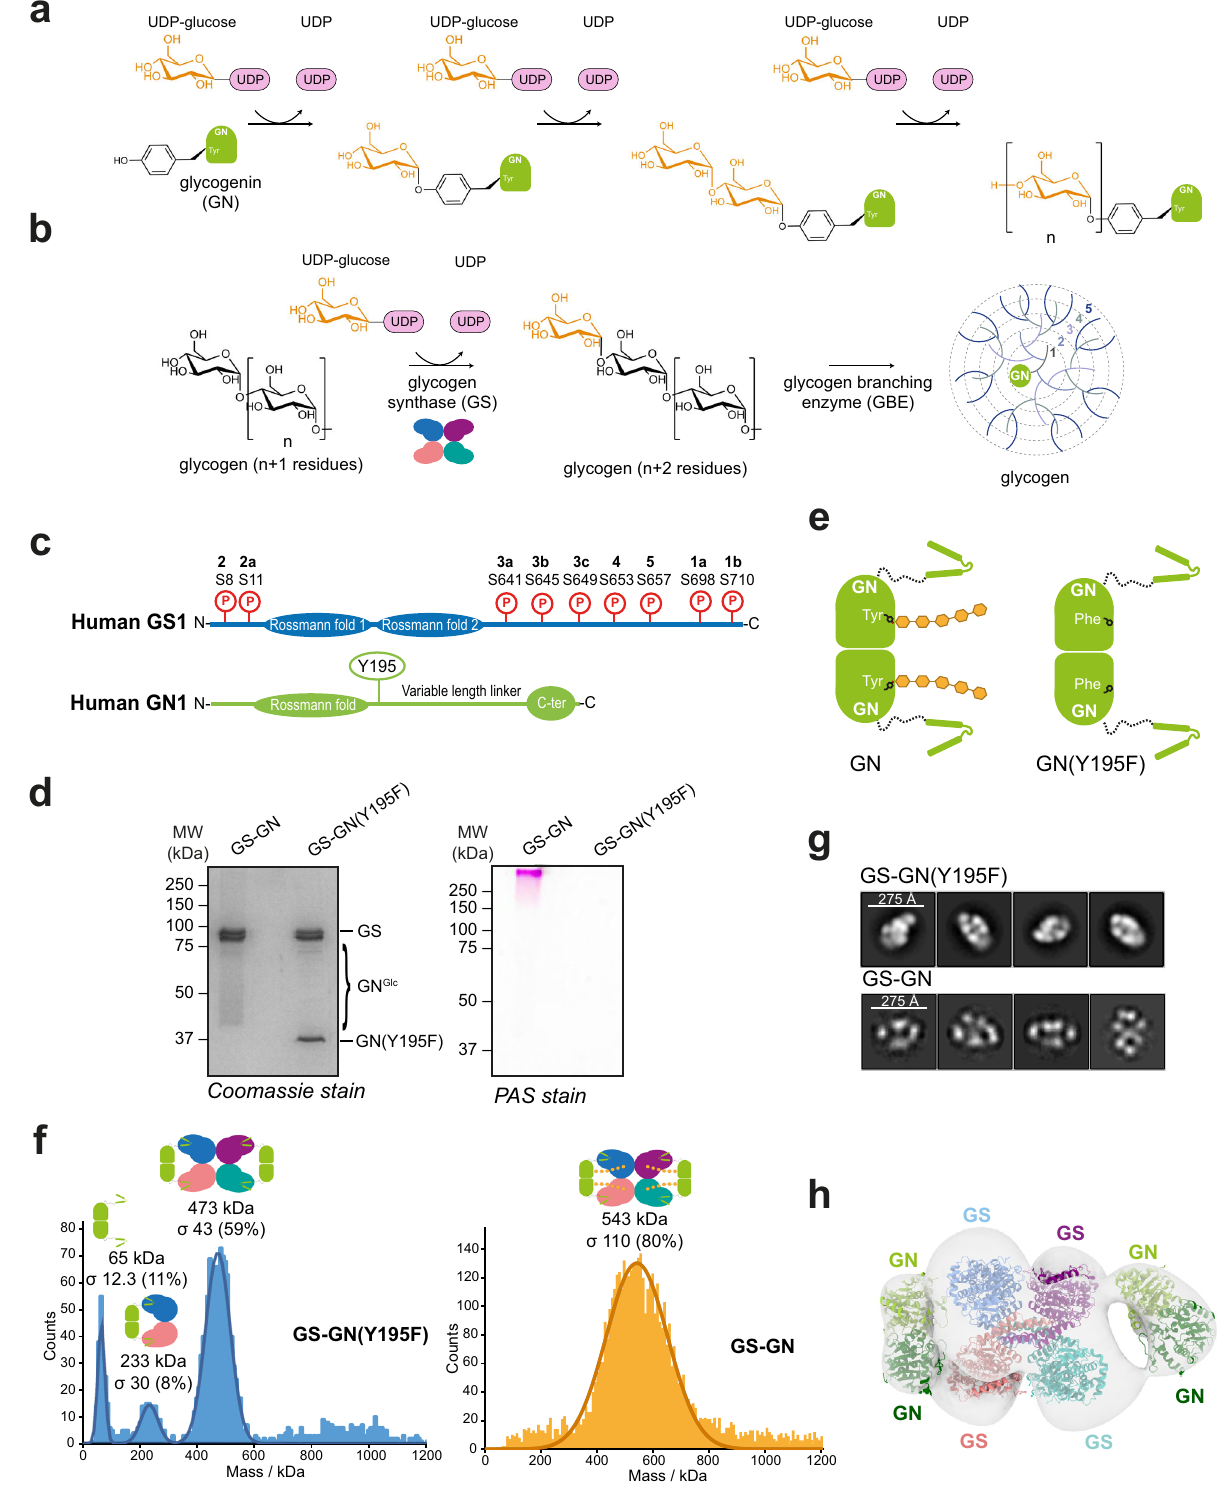
measurements of single molecules in solution. Mass photometry measurements of the GS-GN(Y195F) complex showed a predominant species with an average molecular weight of 473 kDa, which is suggestive of a 4:4 stoichiometry (calculated mass of 485 kDa) (Fig. 1f). Analysis of the GS-GN(WT) sample identi fi ed a species with an average molecular weight of 534 kDa and the measured peak was broader than the non-glucosylated